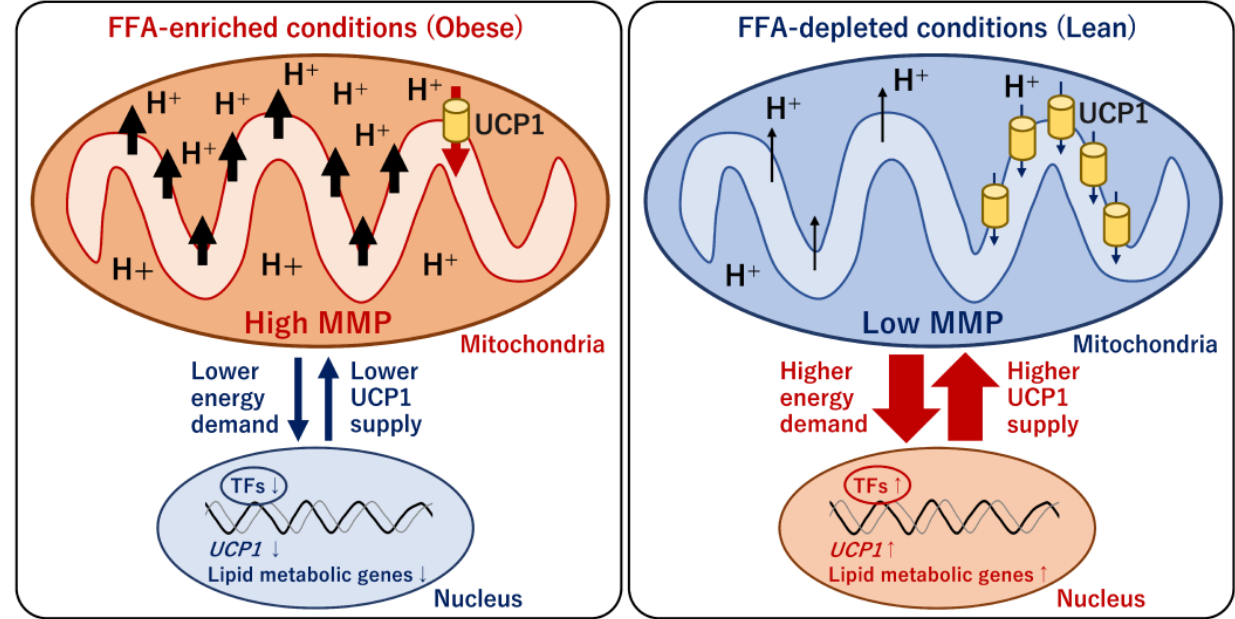
Figure 7. Feedback regulation between UCP1 gene expression and mitochondrial membrane potential (MMP) under different FFA conditions. FFA-enriched conditions induce MMP due to abundant fuels for mitochondrial oxidation; however, the expression of UCP1 and lipid metabolic genes is repressed (left panel). In contrast, FFA-depleted conditions result in lower MMP and the induced expression of UCP1 (right panel). Transcriptional factors such as CEBPA, PPARGC1B, RXRG, LXRA, and RORG exhibited a similar expression pattern to that of UCP1 and the metabolic genes between these FFA conditions; therefore, they may be involved in the feedback regulation. This feedback regulation may be required to coordinate UCP1-mediated thermogenesis under different mitochondrial energy statuses in brown adipocytes.